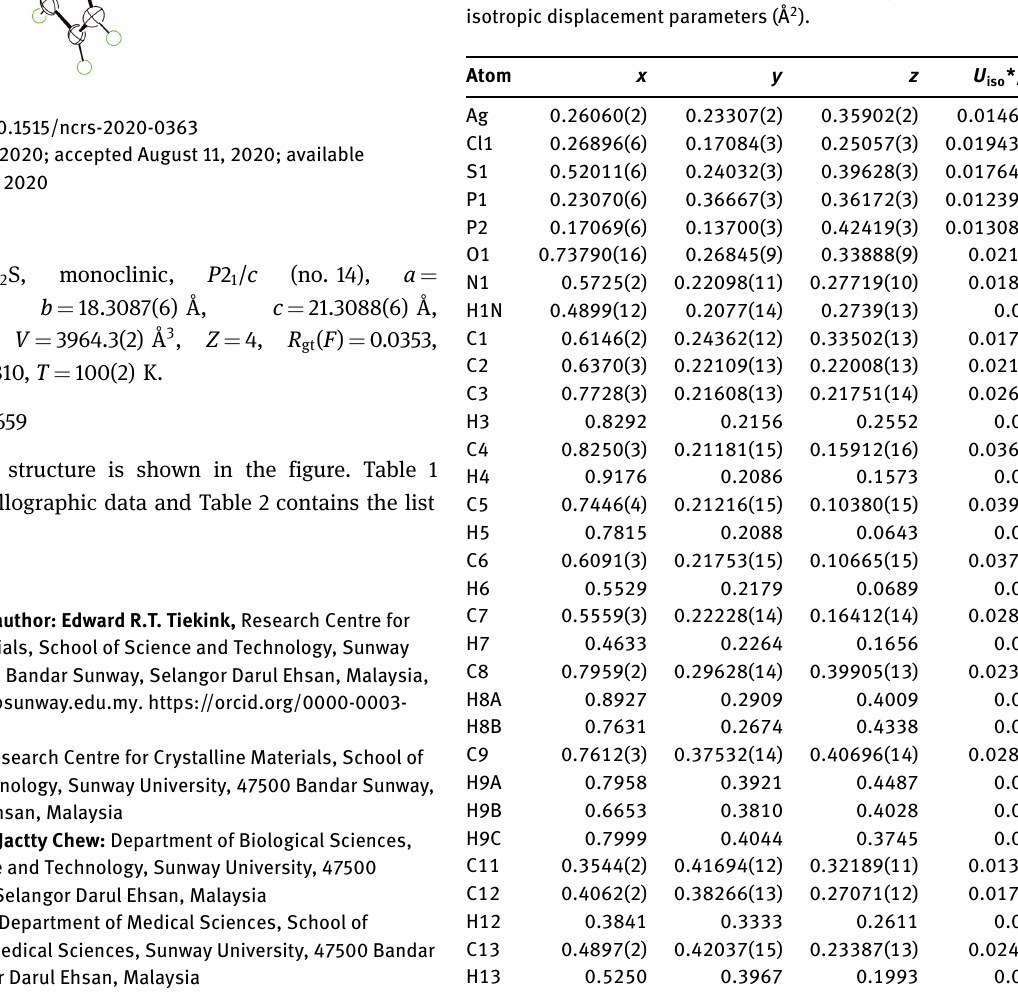
Table 2: Fractional atomic coordinates and isotropic or